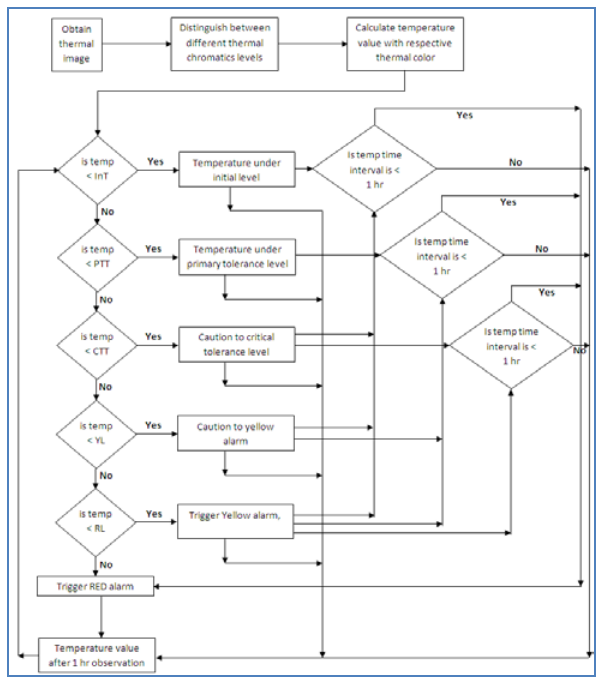
Figure 27. Logic flow for detection of critical